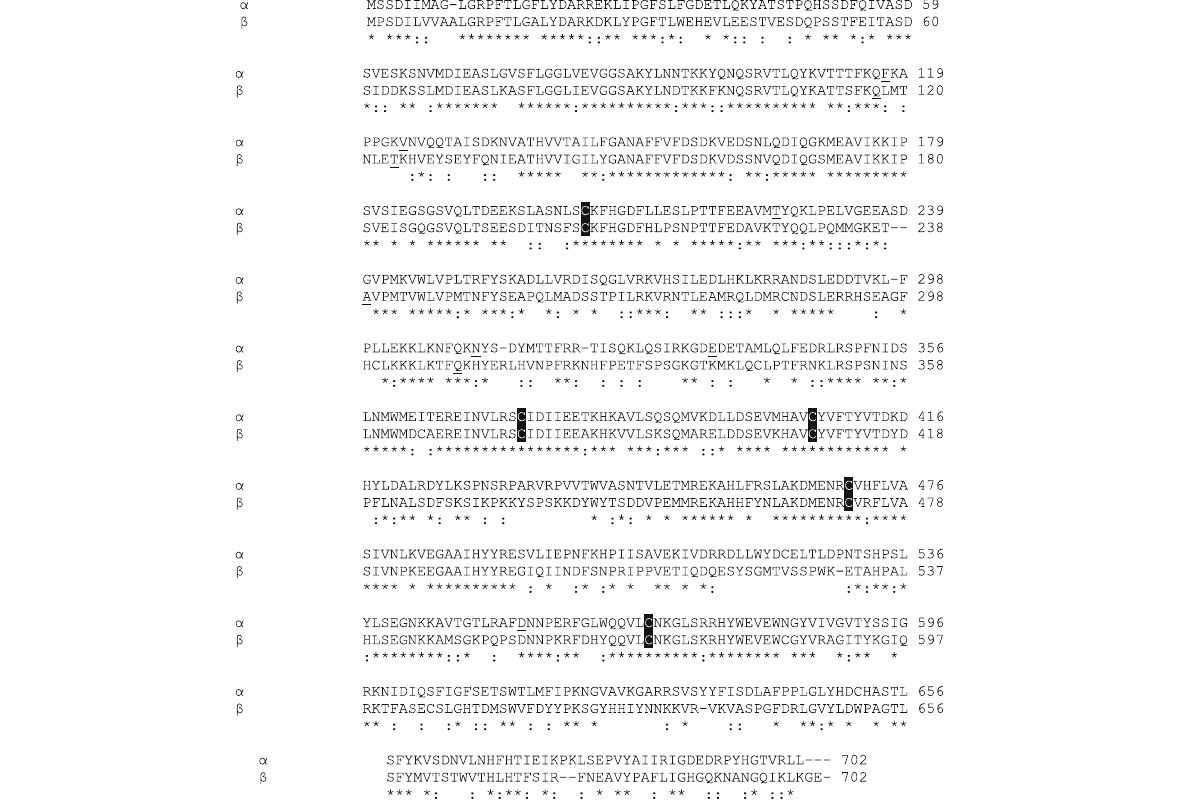
Fig. 3 Sequence alignment between Sp-CTx- α and β -subunits. Sequences were aligned using the ClustalW2 EBI. Single-letter amino-acid notation is used. Amino acids are numbered beginning at the assumed N-terminal Met for both subunits. Identical residues are shown by asterisks, whereas conservative substitutions are indicated by colons. Conserved cysteine residues are highlighted in white on a black background. An amino acid with potential for glycosylation is